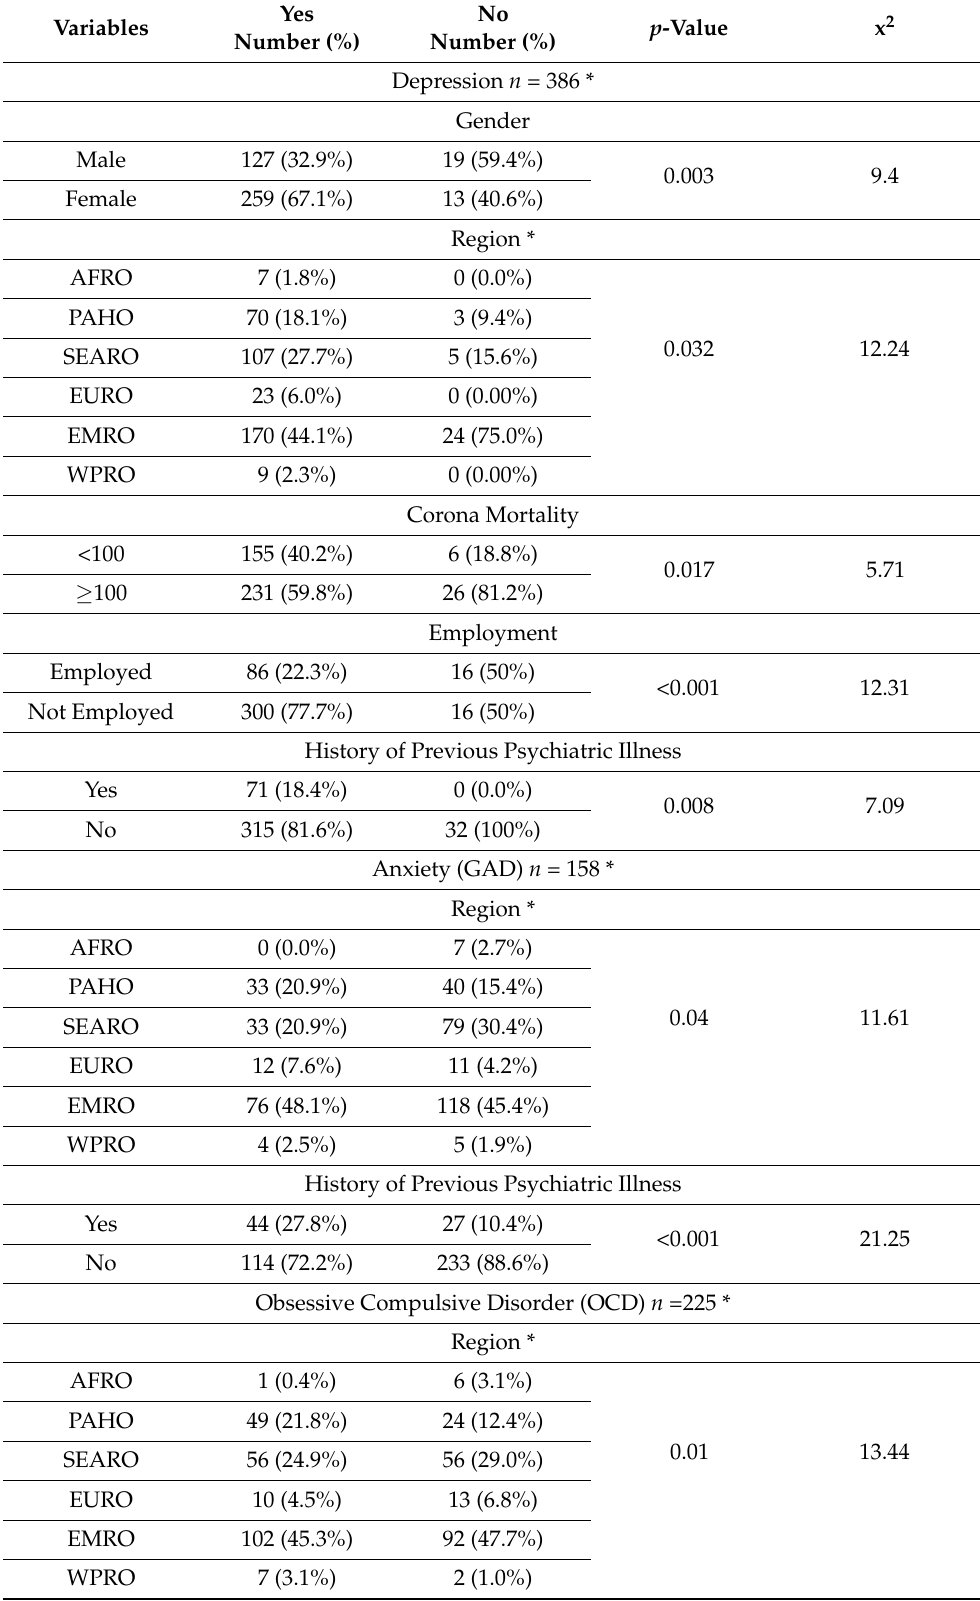
Table 4. Relation of Psychiatric Illness with background